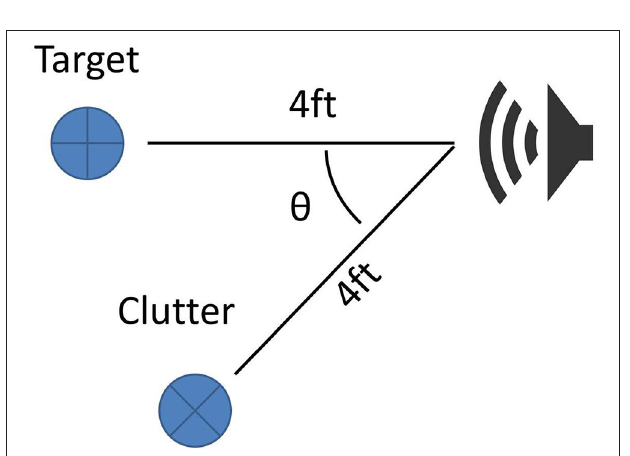
FIGURE 13 | Clutter rejection using beam shaping. The sonar system faces a target that is 4 ft away. The clutter object is also 4 ft from the sonar but is rotated around the sonar system, changing its angle in the view of the sonar.